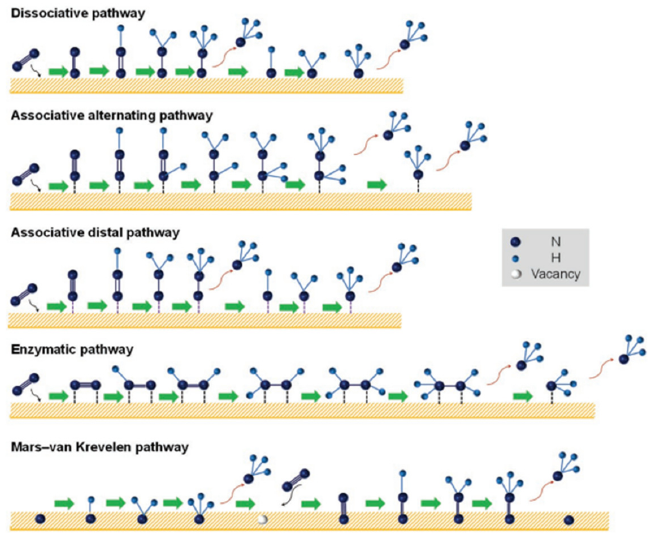
Figure 2. Electrocatalytic NRR reaction mechanism [26].